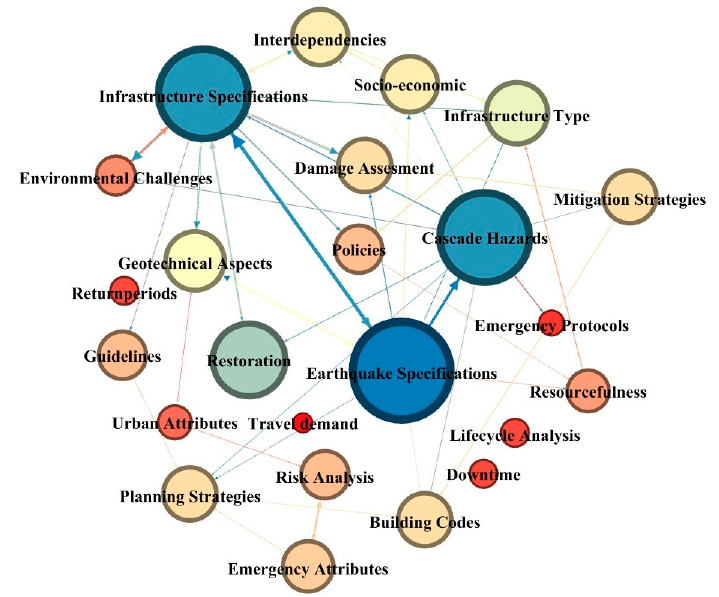
Figure 10. CIR indicators/variables map view The arrows represent the correlation between the indicators, while the size indicates the importance of the indicators used to measure critical infrastructure resilience.